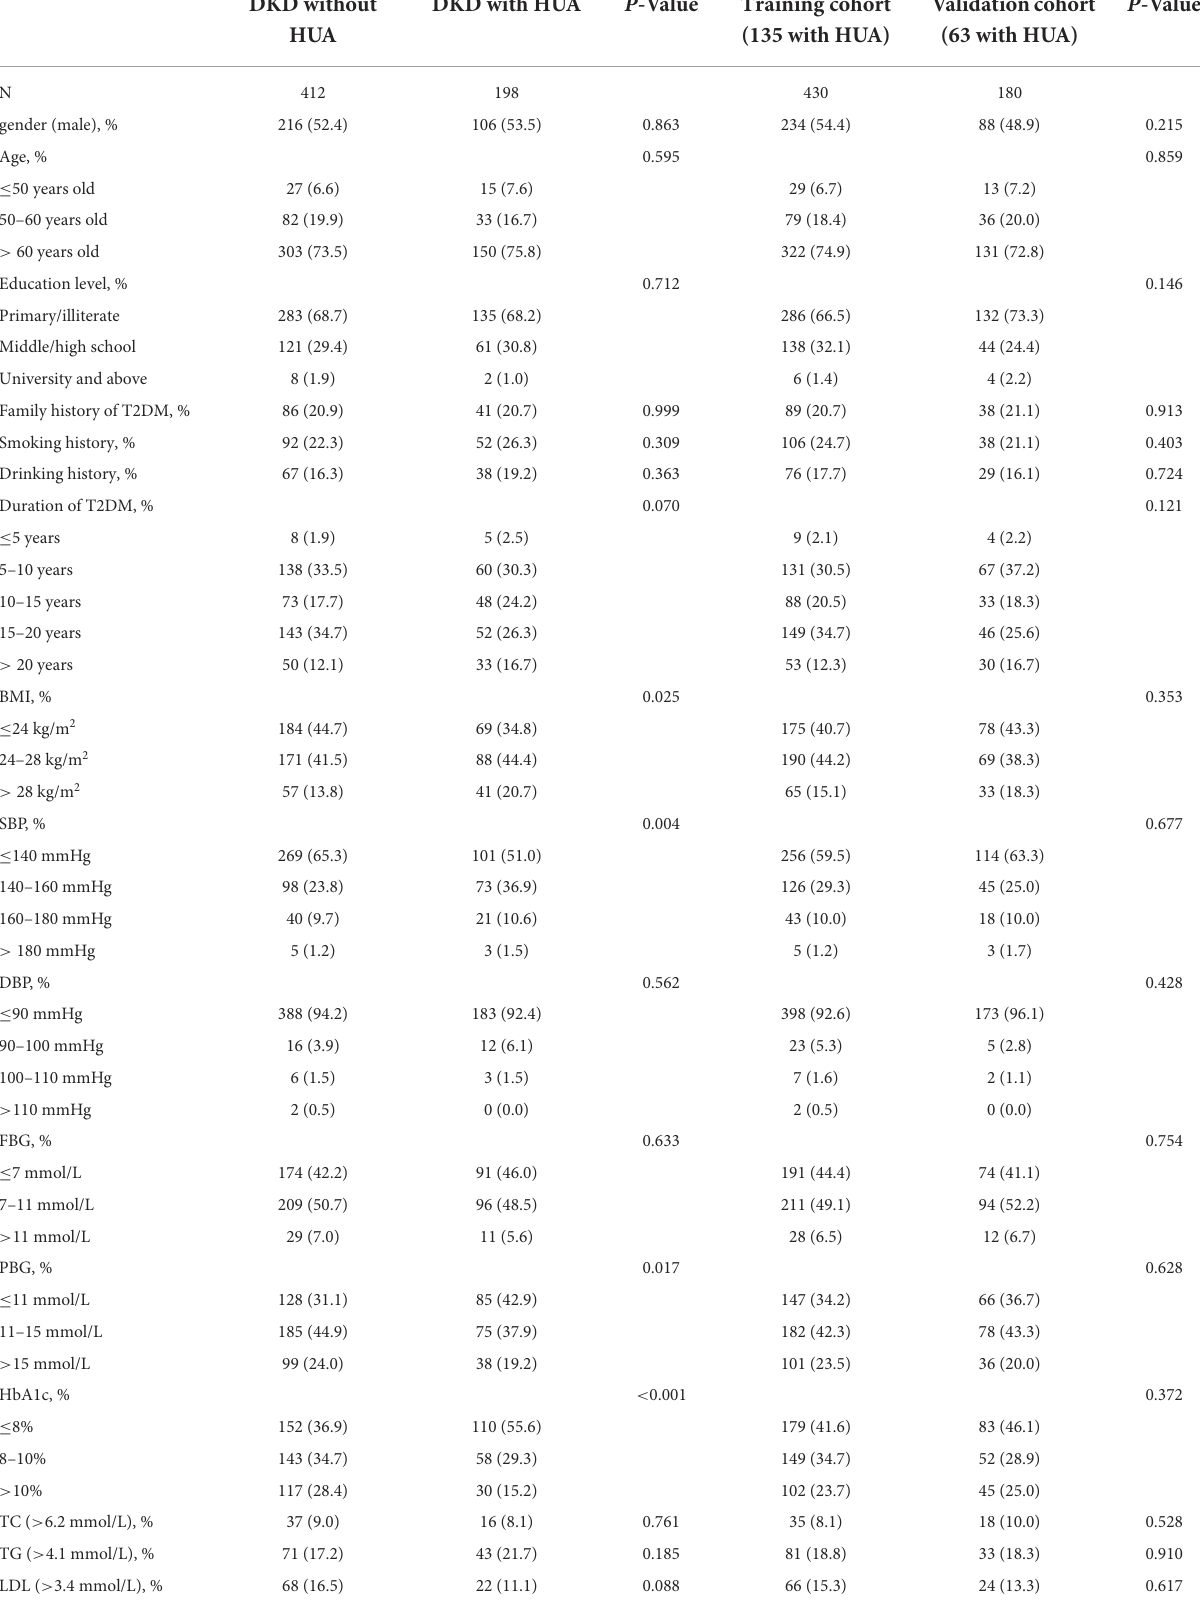
TABLE 1 Characteristics of participants in different